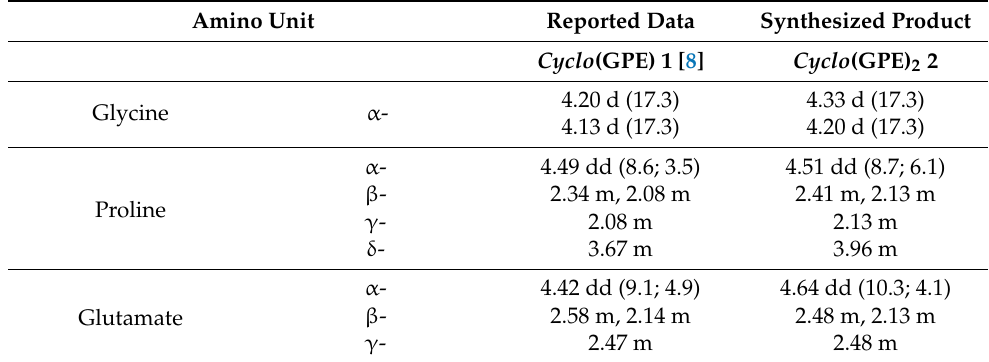
Table 3. 1 H-NMR data of cyclo (GPE) 1 [8] and cyclo (GPE) 2 2 in CD 3 OD/D 2 O.